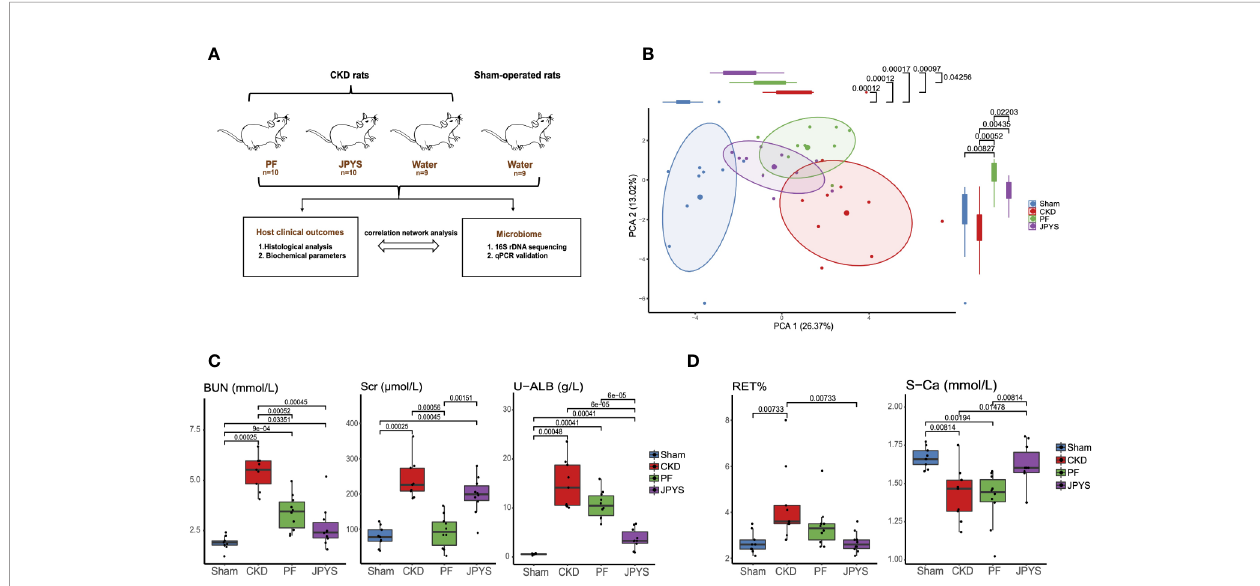
FIGURE 1 | Distinct host responses to JPYS and PF in the CKD rats. (A) Study design to evaluate the responses of the CKD rats and their gut microbiota to JPYS or PF. (B) Principal component analysis (PCA) of clinical parameters of the sham-operated, CKD, JPYS and PF rats after 12 weeks of treatment (Sham: n = 9, CKD: n = 9, JPYS: n = 10 and PF: n = 10). Overall clinical variation of the four treatment groups was assessed along PC1 and PC2 respectively. (C) Variation of clinical parameters of kidney function in each group. (D) Variation of clinical parameters of CKD complications in each group. Statistical signi fi cance of variation between groups was tested by Wilcoxon rank-sum test with FDR correction. Only signi fi cant differences between groups ( p < 0.05) were annotated. JPYS, Jian-Pi-Yi-Shen decoction; PF, Piperazine ferulate; CKD, chronic kidney disease; BUN, blood urea nitrogen; U-ALB, urinary albumin; RET, reticulocyte; S-Ca, serum calcium